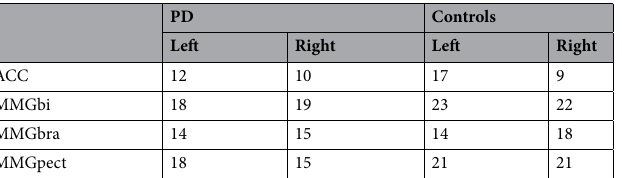
Table 2. Included signals. Included signals after considering the necessary signal to noise ratio (SNR) of > 10 dB of raw signals differentiated by sensor and